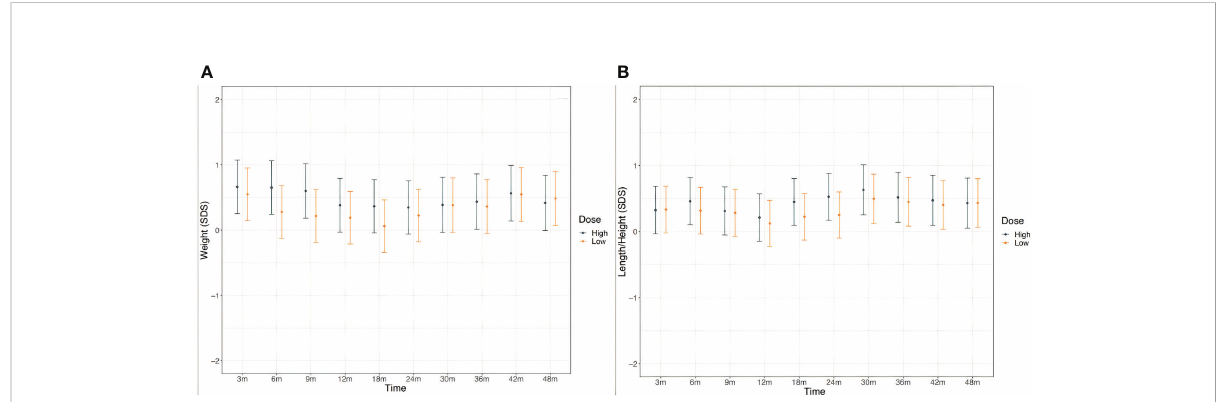
FIGURE 3 Weight (A) and height (B) in CH patients in the two treatment groups throughout the study. According to study protocol, enrolled patients underwent clinical evaluation at the enrollment, 10 days after L-T4 start and subsequently at the chronological age of 1.5, 3, 6, 9, 12, 18, 24, 30, 36, 42 and 48 months of